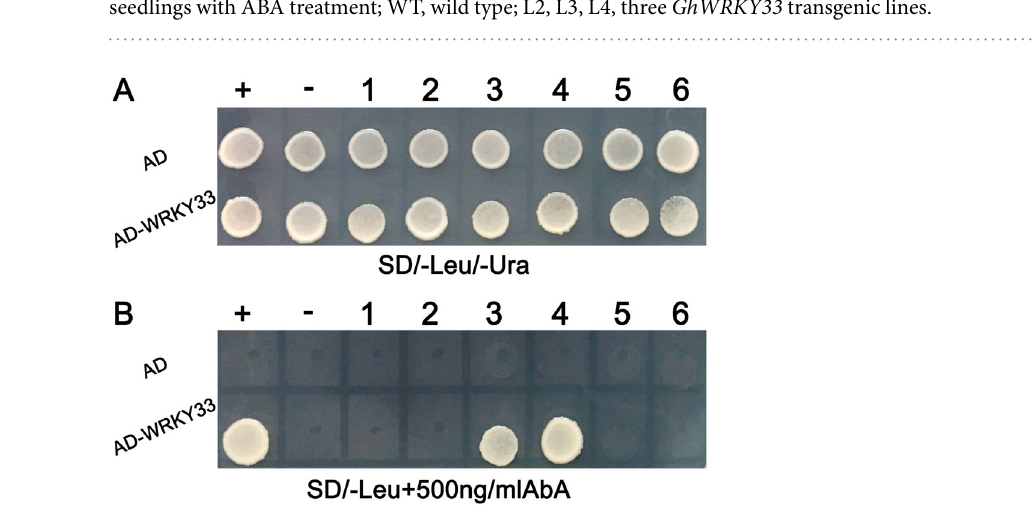
Figure 9. Yeast one-hybrid assay of GhWRKY33 binding to promoters of the drought stress-related and ABA- responsive genes. Yeast cells carrying pGAD-GhWRKY33 or pGAD7 were grown on SD/-Leu/-Ura or SD/-Leu containing 500 ng/ml AbA. + , pAbAi-W-box; − , pAbAi-mW-box; 1, pAbAi-RD29Apro; 2, pAbAi-DREB2Apro; 3, pAbAi-ERD15pro; 4, pAbAi-SOS2pro; 5, pAbAi-ABI1pro; 6: